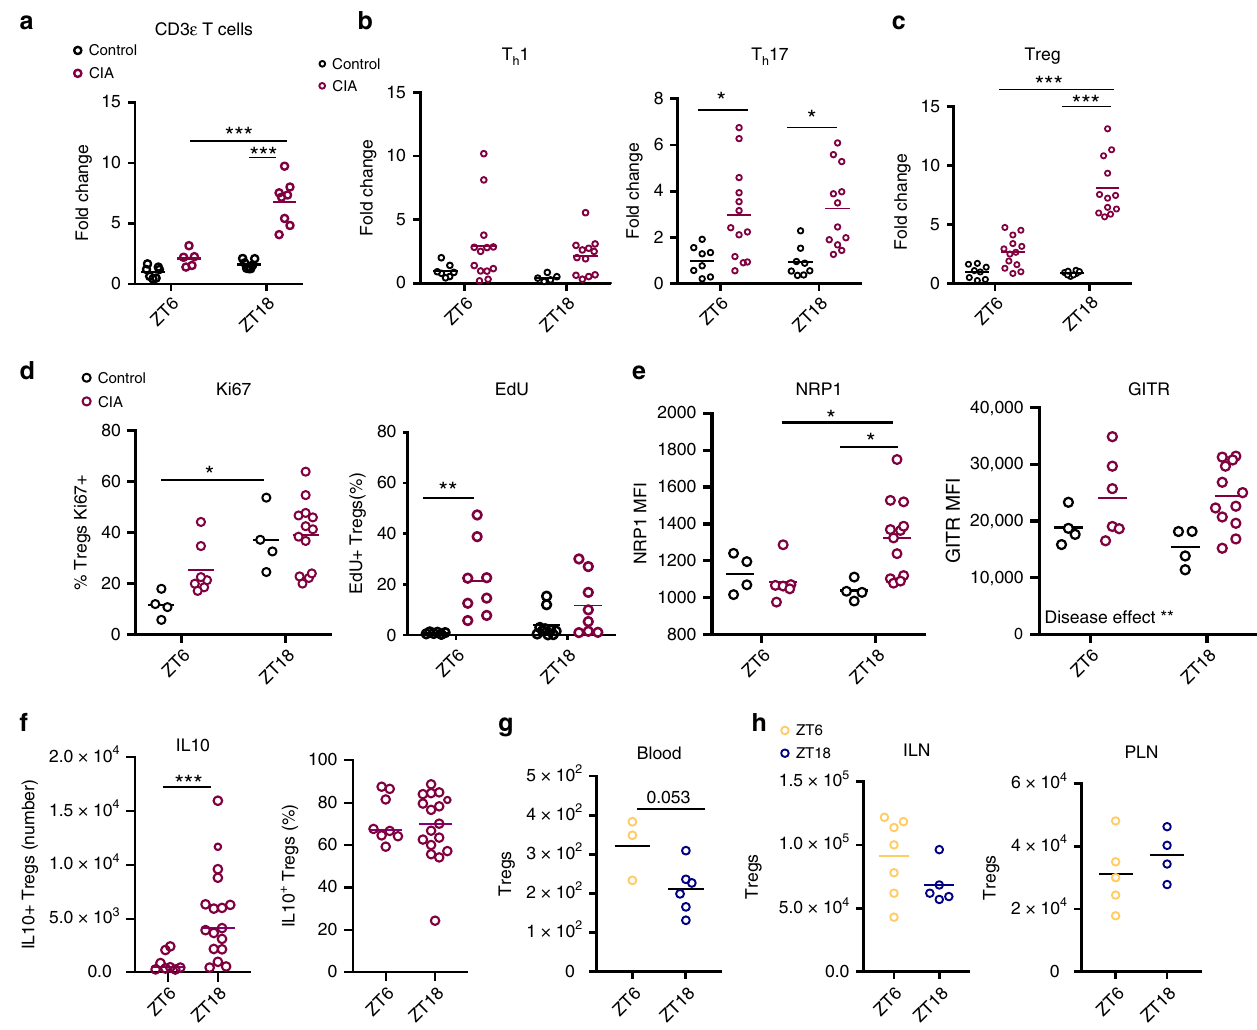
Fig. 2 Diurnal variation in T cell populations within in fl amed joints. a CD3 ε T cells (CD45 + /CD11b − /CD3 ε + ) in limbs harvested from control and arthritic mice at ZT6 (control n = 7; CIA n = 5) and ZT18 (control n = 7; CIA, n = 8), data normalised to CD3 ε T cell numbers in control limbs at ZT6, two- way ANOVA and Bonferonni post hoc tests. b Quanti fi cation of CD4 + T cell subsets (T h 1 and T h 17) in limbs at ZT6 (T h 1: control n = 7; CIA n = 13; T h 17: control n = 8; CIA n = 13) and ZT18 (T h 1: control n = 5; CIA n = 12; T h 17: control n = 8; CIA n = 12), data pooled from two separate experiments and normalised to ZT6 control animals, two-way ANOVA and post hoc Bonferonni. c Quanti fi cation of Tregs in limbs at ZT6 (control n = 8; CIA n = 13) and ZT18 (control n = 8; CIA n = 12), data pooled from two separate experiments and normalised to ZT6 control animals, two-way ANOVA and post hoc Bonferonni. d Expression of the proliferation markers Ki67 (ZT6: control n = 4; CIA n = 7; ZT18: control n = 4; CIA n = 13) and EdU (ZT6: control n = 6; CIA n = 8; ZT18: control n = 10; CIA n = 8) on Tregs isolated from control and in fl amed joints, Kruskal – Wallis test and post-hoc Dunn ’ s test. e Expression of NRP1 and GITR (ZT6: control n = 4; CIA n = 6; ZT18: control n = 4; CIA n = 12) on Tregs isolated from control and in fl amed joints, two-way ANOVA and post-hoc Bonferonni test. NRP1 — interaction between time-of-day and disease effect ( p = 0.0285); GITR — disease effect ( p = 0.0077). f IL10 expression by stimulated Tregs isolated from in fl amed joints at ZT6 ( n = 8) and ZT18 ( n = 17) expressed as total number of IL10 + Tregs and % of Tregs that are IL10 + , Mann – Whitney test. g Quanti fi cation of Tregs in blood of arthritic mice (ZT6 n = 3; ZT18 n = 6), two-sided unpaired T -test. h Quanti fi cation of Tregs in inguinal (ZT6 n = 7; ZT18 n = 5) and popliteal (ZT6 n = 5; ZT18 n = 4) lymph nodes from arthritic mice. Treg numbers were determined per lymph node, only popliteal lymph nodes draining in fl amed limbs were analysed, two-sided unpaired T tests. All graphs show individual data points with mean values. In all panels statistical signi fi cance between indicated groups is shown as * p < 0.05, ** p < 0.01 and *** p < 0.005. Source data are provided as a Source Data fi le. (Fig. 3a). Splenic Tregs sorted from wildtype mice (PER2::luc that Per2 , Bmal1 , Cry1 and Per3 did not show rhythmicity. Bmal1 fl ox/ fl ox ) at ZT6 and ZT18 showed negligible diurnal varia- However, Rev-erb α did show signi fi cant differences in expression tion in expression of the core clock genes Per2 , Bmal1 and Cry1 , between time-points, peaking at ZT6. To con fi rm that antibody but signi fi cant diurnal variation in Rev-erb α . Deletion of Bmal1 staining does not affect clock gene expression in Tregs, FoxP3 GFP cells were sorted from the lymph nodes of DEREG mice at ZT6 caused down-regulation of Rev-erb α and up-regulation of Cry1 as and ZT18 (with no prior antibody staining). Quanti fi cation of expected 25 , but no effect on Per2 (Fig. 3b). To characterise cellular circadian clock function with greater temporal resolution, Tregs clock gene expression in these cells yielded concurrent results were sorted from lymph nodes of naïve mice culled at 6 h intervals con fi rming lack of diurnal variation in all genes tested except Rev- (Fig. 3c and Supplementary Fig. 5a, b). QPCR analysis revealed erb α (Supplementary Fig. 5c, d). These data suggest that within NATURE COMMUNICATIONS| (2020) 11:1658